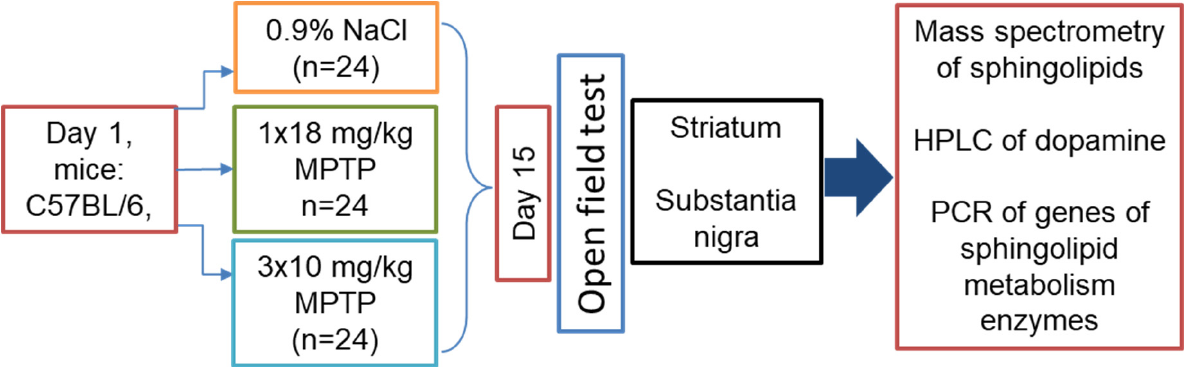
Figure 1. Design of experiments for modeling Parkinson’s disease at the preclinical and clinical stages in C57BL/6 mice by subcutaneous administration of 1-methyl-4-phenyl-1,2,3,6-tetrahydropyridine (MPTP), once at a single dose of 18 mg/kg and three times at a single dose of 10 mg/kg, with a 2-h interval between injections, respectively. In the controls, saline was administered.